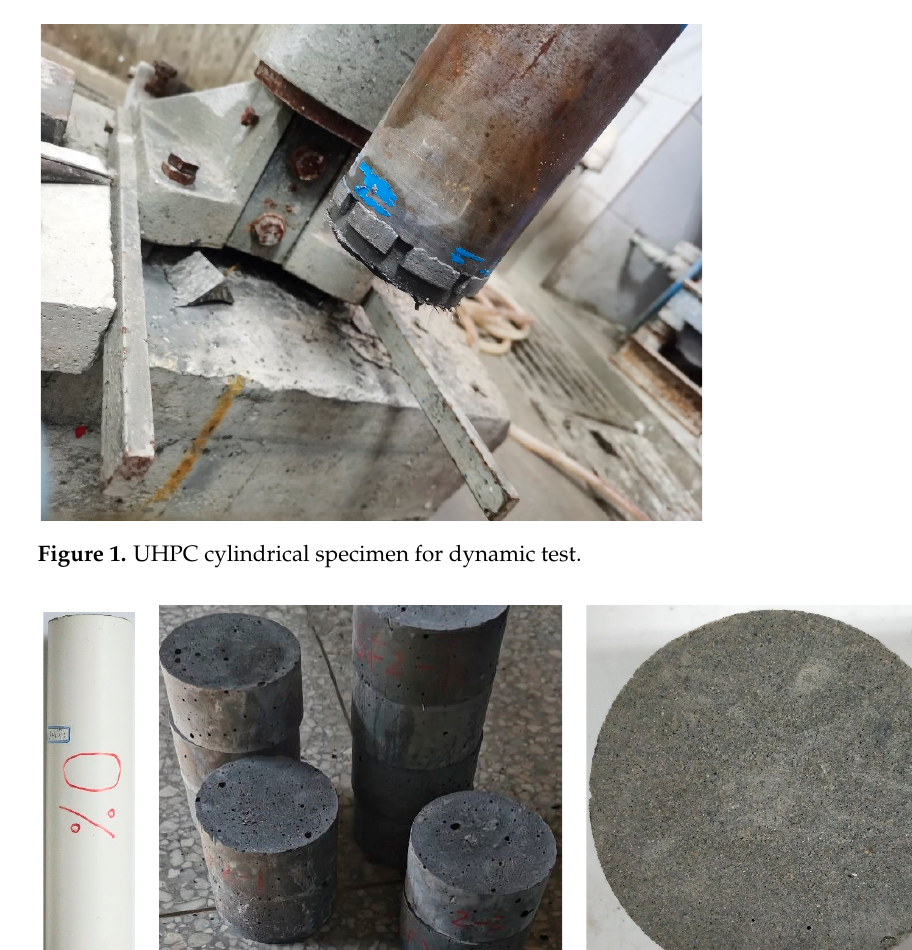
Figure 2. Preparation of normal UHPC specimen. ( a ) PVC pipe ( b ) Cylindrical specimen ( c ) The specimen after grinding.